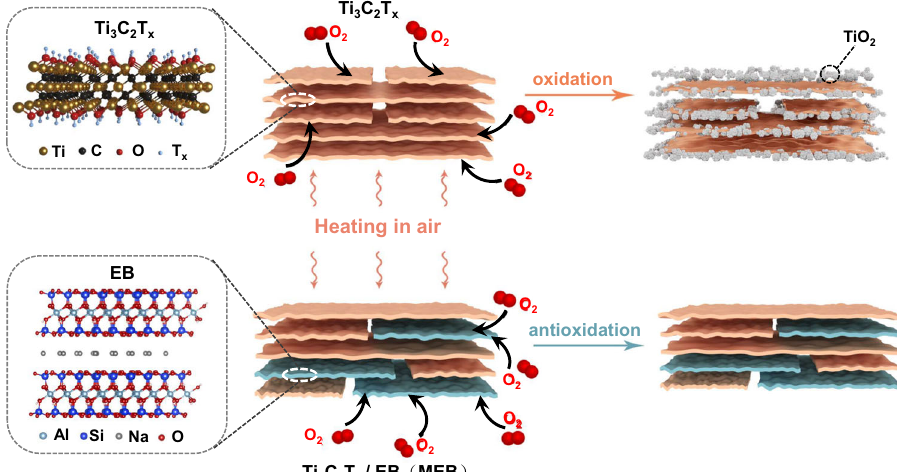
Fig. 1 | Schematic shows the oxidation process of pristine Ti3C2T x (starting from the edge) and suppressed oxidation of MEB under high-temperature annealing with the presence of oxygen. The top row shows the oxidation of pristine Ti 3 C 2 T x , which is induced by interacting with oxygen molecules, and Ti 3 C 2 T x fi nallytransformstoTiO 2 .Thebottomrowshowsthesuppressedoxidation